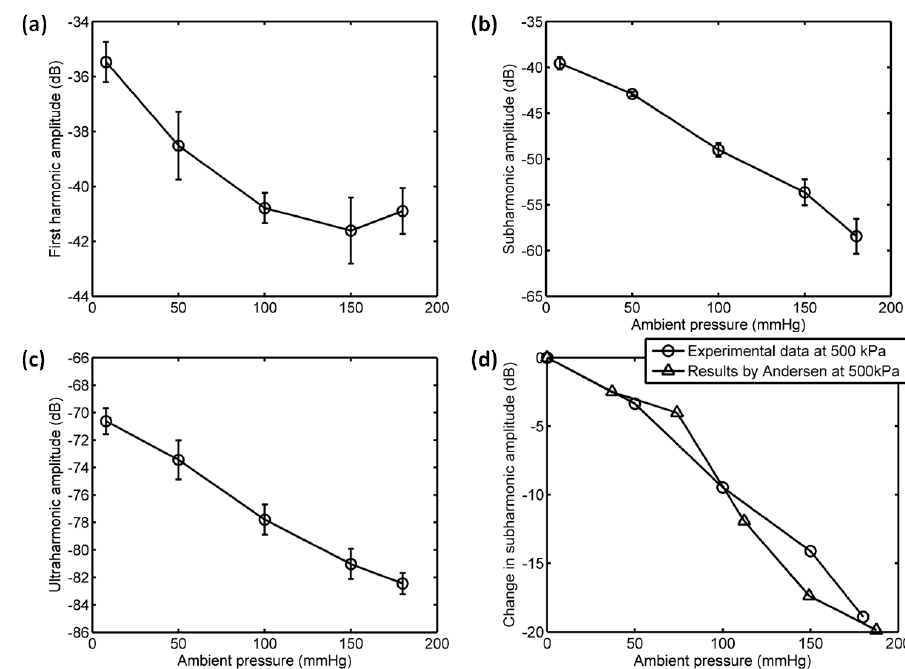
Figure 16. The relationships between the frequency components of the microbubbles’ scattered signals and the overpressure. ( a ) The first harmonic amplitude vs. ambient pressure, ( b ) the subharmonic amplitude vs. ambient pressure, ( c ) the ultraharmonic amplitude vs. ambient pressure, and ( d ) the comparison between the measurement in this study and the reported experimental results. The driving frequency was 4 MHz, the acoustic pressure was 500 kPa. The transmitted tone burst with 64 cycles had a PRF of 1 kHz.